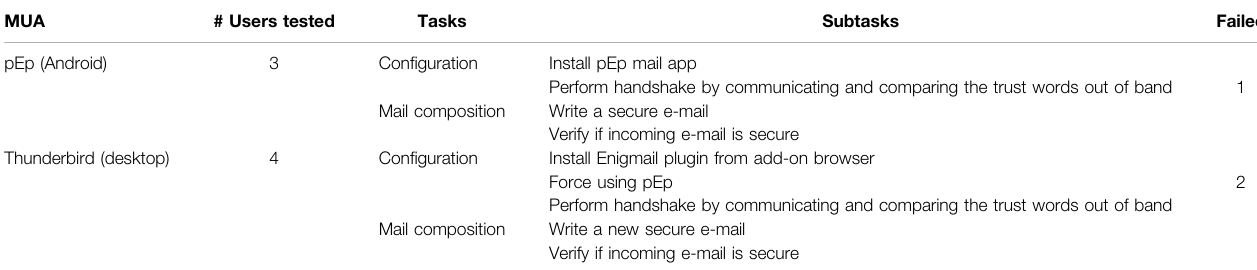
TABLE 10 | User testing results for pEp regarding the number of users who tested an MUA and who failed for a speci fi c